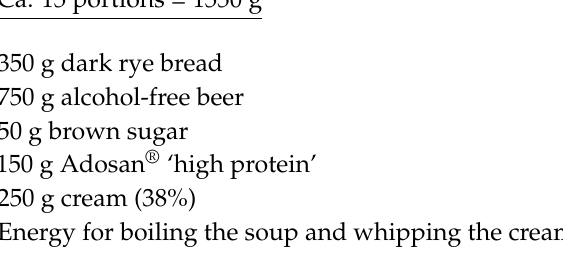
Procedure: Hydrate the rye bread in the beer for half an hour. Add brown sugar and Adosan ® . Blend the soup and boil it at medium heat for ca. 5 min while